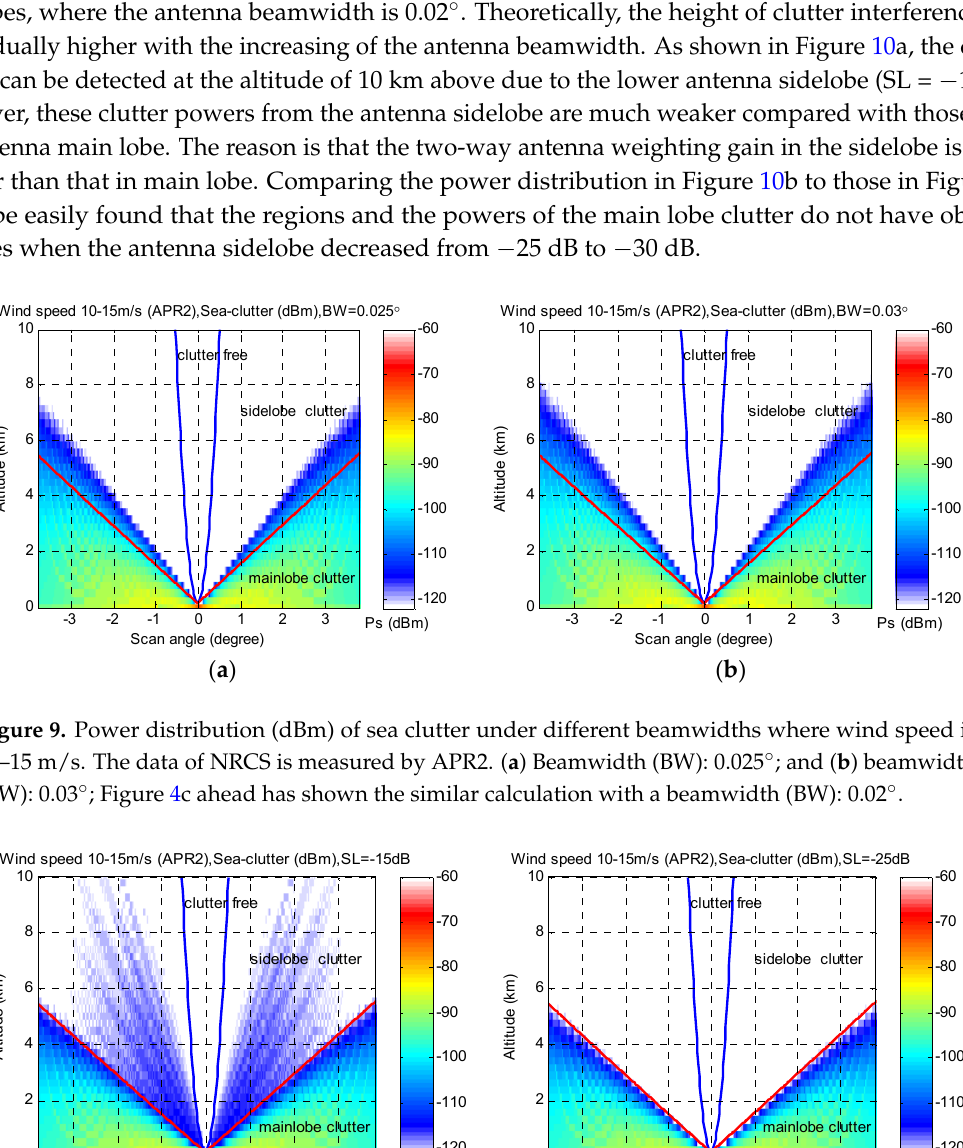
Scan angle (degree) Figure 10. Power distribution (dBm) of sea clutter under different antenna sidelobe, where wind speed is 10–15 m/s. The data of NRCS is measured by APR2. ( a ) antenna side lobe : SL = − 15 dB; and ( b ) antenna side lobe: SL = − 25 dB.